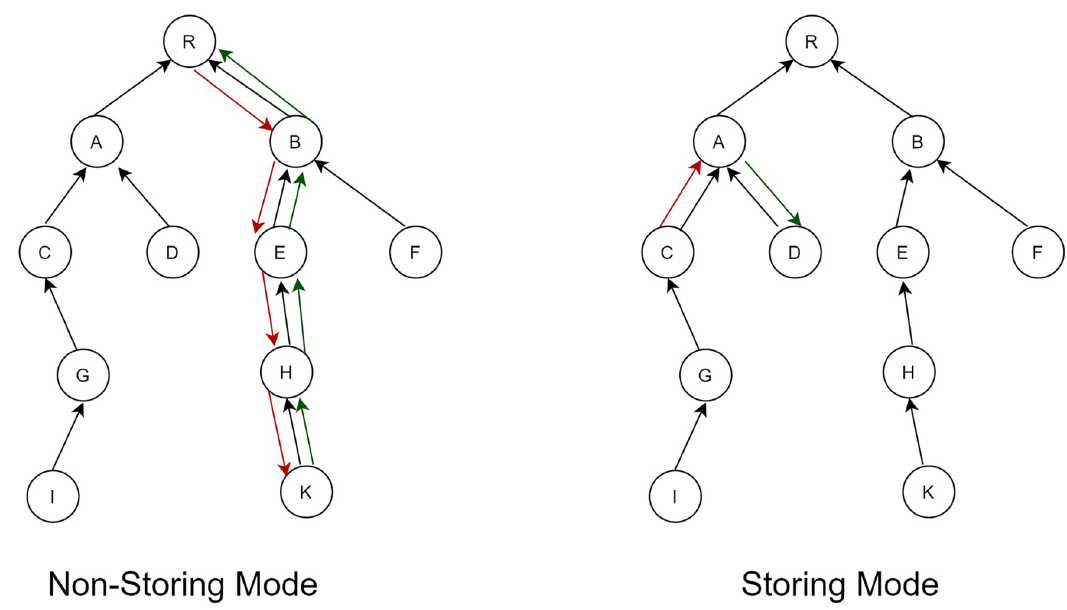
Fig 12. Sybil attack in